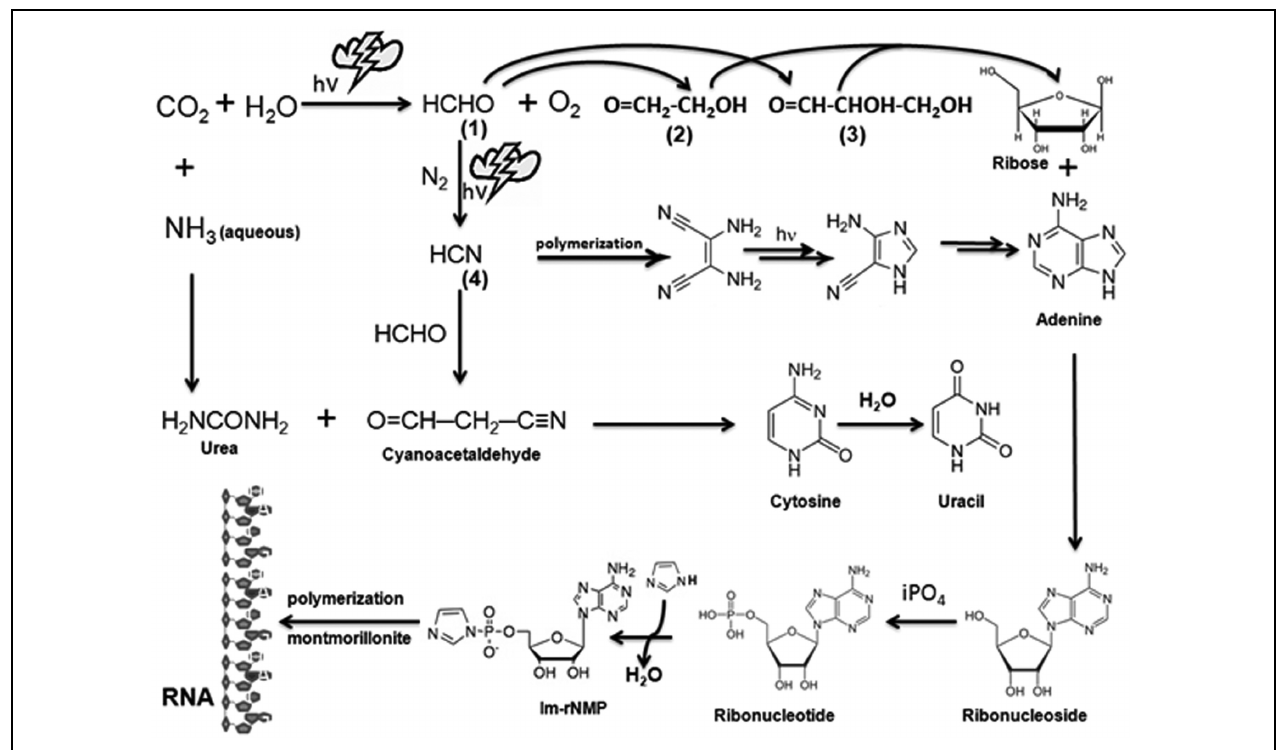
FIGURE 1 | Prebiotic synthesis of ribose, purines, pyrimidines, and RNA. Simple inorganic molecules such as CO 2 , H 2 O, HCHO, NH 3 , and HCN, can be combined to form organic ribose sugar as well as nitrogenous bases (purines and pyrimidines) by selectively subjecting them to electrical discharges representing the proposed extreme weather conditions in the prebiotic world. The highly reactive molecule formaldehyde (1) can be generated by reacting abundant CO 2 that was present in the reducing world with water molecules. Subsequent reaction of HCHO with itself can give rise to ribose sugar via intermediates such as glycoaldehyde (2) and glyceraldehydes (3) or another reactive molecule HCN by reacting with N 2 under high atmospheric pressure. HCN reacts with itself to produce the purine base adenine and, with HCHO, it produces cyanoacetaldehyde, which can react with urea (H 2 NCONH 2 ) to give rise to two pyrimidine bases, namely cytosine and uracil. Ribose sugar bonds with nitrogenous bases to produce ribonucleosides which might have been phosphorylated by inorganic phosphate (iPO 4 ) from dissolved minerals to produce ribonucleotides (Costanzo et al., 2007). These ribonucleotides are activated by imidazole (Im) and then polymerize into a long chain without any template on a clay catalyst such as montmorillonite, which was abundantly present in the prebiotic Earth. All these steps vest on the probability of occurrence of all these ingredients and favorable conditions at least in a close proximity to the Earth surface and its proximal atmosphere. Thymine, found only in DNA, is speculated to have been synthesized with more complex reactions at a later evolutionary stage, possibly through methylation of uracil using hydrazine (H 2 NNH 2 ) and